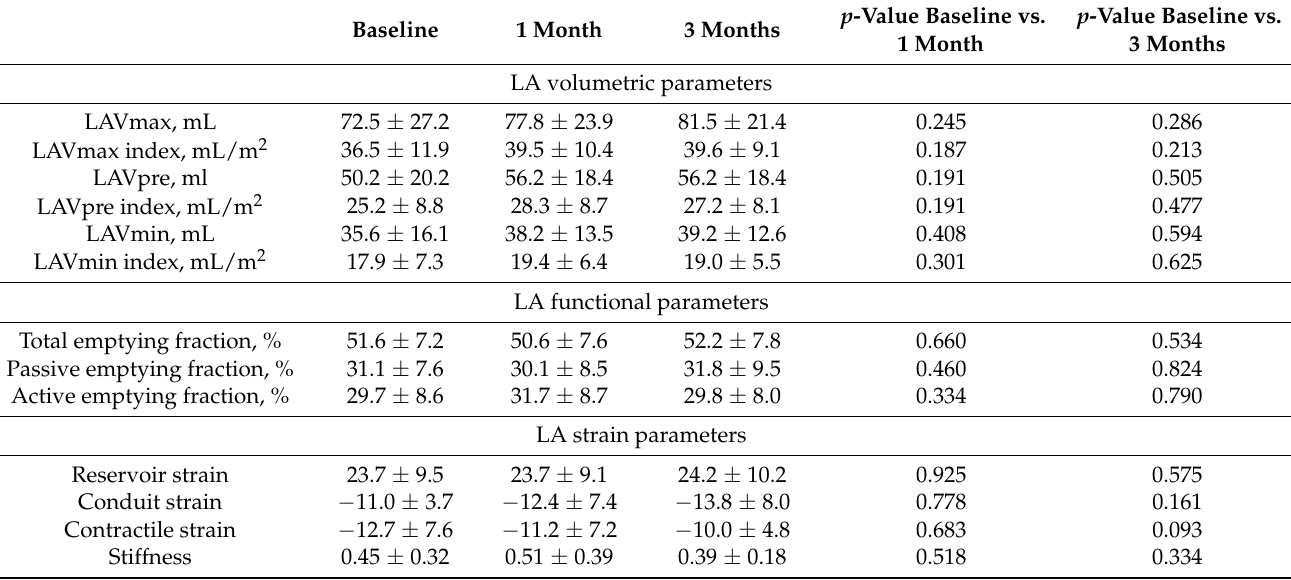
Table 5. Low right atrial low right ventricular pacing